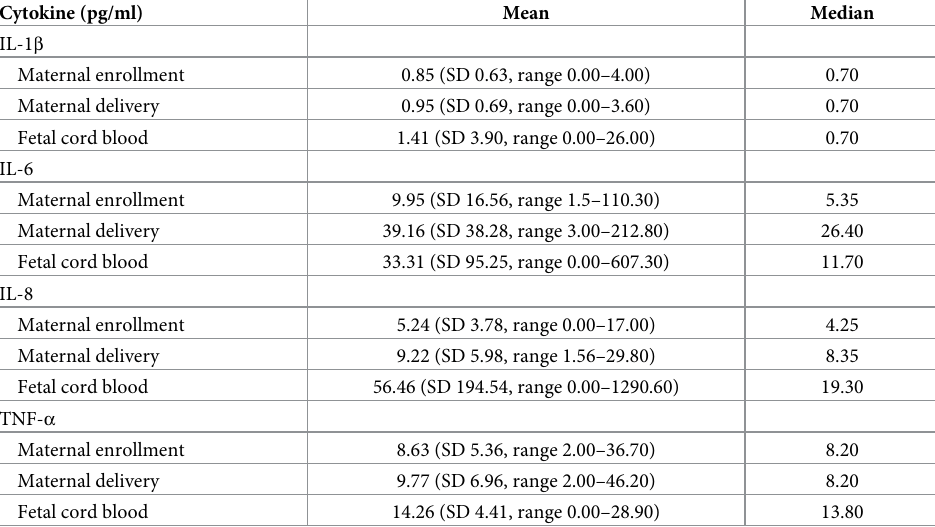
Table 2. Mean and median values of maternal cytokines at enrollment and delivery and fetal cord blood at delivery. Cytokine (pg/ml) Mean